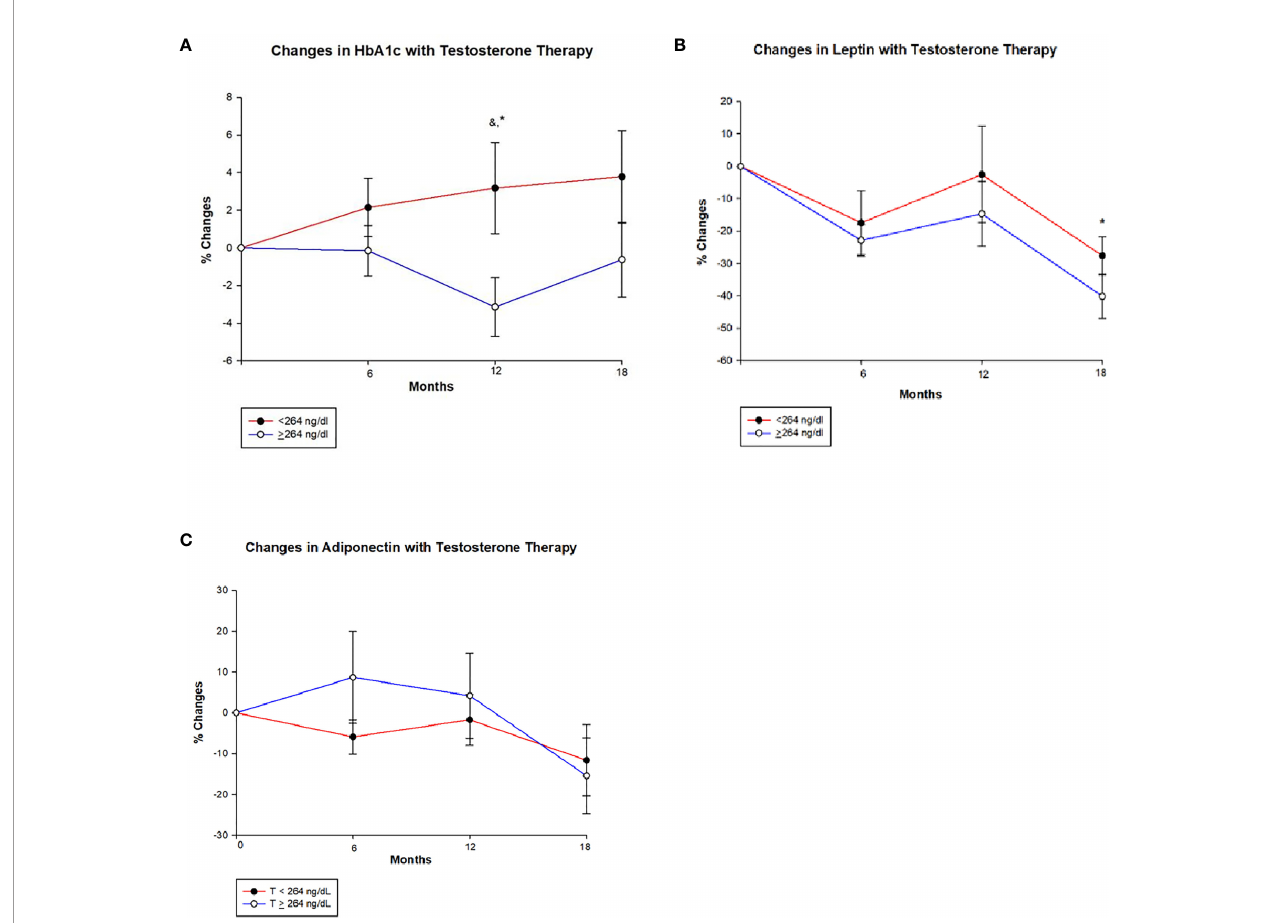
FIGURE 2 | Changes (%) in glycated haemoglobin (HbA1c), leptin and adiponectin with testosterone (T) therapy according to baseline testosterone level. T <264 ng/ dL (red line), T ≥ 264 ng/dL (blue line). & Unadjusted P < 0.05, *Adjusted P value <0.05, adjusted for baseline. (A) Among men with T <264 ng/dL, HbA1c shows a non-signi fi cant trend towards increase from baseline value at 6, 12 and 18 months, whereas men with T ≥ 264 ng/dL show a signi fi cant reduction in HbA1c at 12 months (Unadjusted p = 0.030 and adjusted p = 0.005) compared to those with < 264 ng/dL. However this signi fi cance is lost at 18 months in those T ≥ 264 ng/dL. (B) In both groups leptin levels decline from baseline at 6 months and appear to stabilize at 12 months, but at 18 months there is a greater decline in those with T ≥ 264 ng/dL compared to <264 ng/dL (p = 0.034). (C) Adiponectin levels shows an interesting trend, men in group with T < 264 ng/dL show an initial decline followed by a slight increase and a large decline at 18 months, whereas those with T ≥ 264 ng/dL show an initial increase in adiponectin followed by a steep decline from 12 to 18 months time point. However, no signi fi cant between-groups were